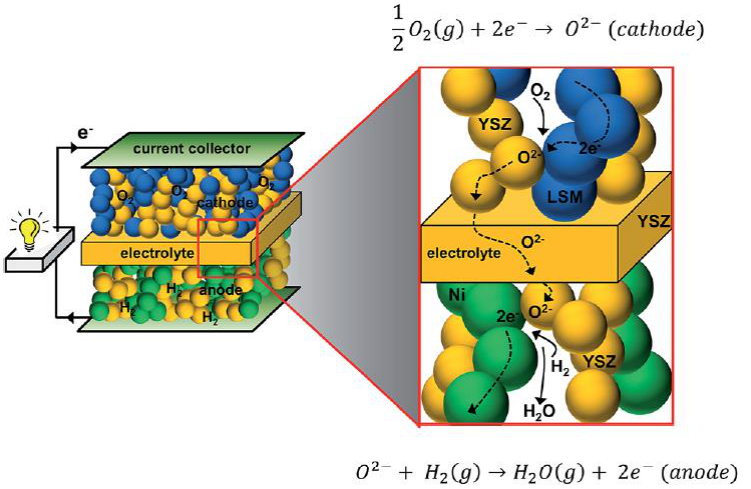
Figure 3. Schematic diagram for SOFC structure (left) and operation mechanism (right)